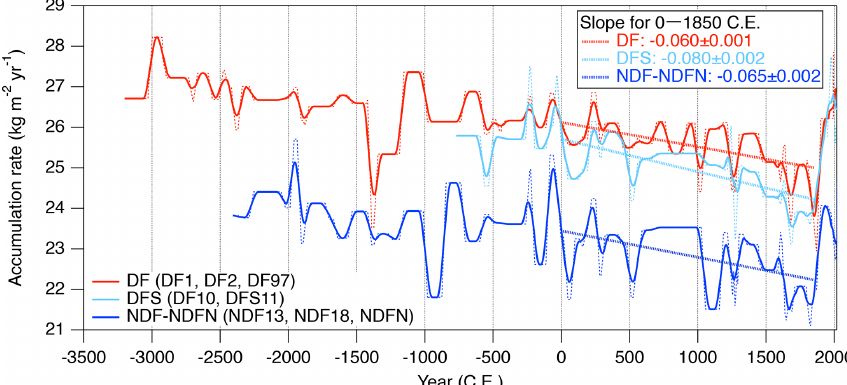
Figure 10. SMB composites for the DF, DFS and NDF regions. The DF stack was calculated as a simple average of the SMB data of the DF1, DF2 and DF1997 cores after smoothing each record with a 31-year moving average (dotted line). The solid line indicates the SMB stack with a 71-year moving average. The DFS and NDF stacks were calculated in the same manner as the DF stack using DFS2010 and DFS2011 for the DFS stack and NDF2013, NDF2018 and NDFN for the NDF stack. The dashed line indicates a statistically significant trend for